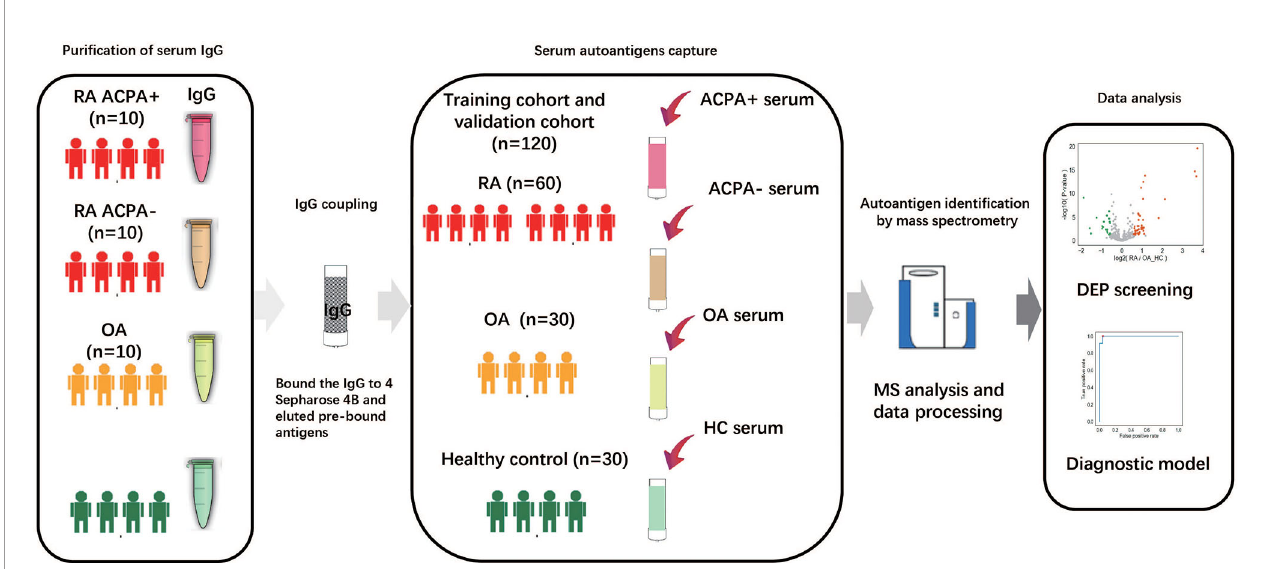
FIGURE 1 | Study overview and antigenome characterization. Overview of the study cohort and schematic work fl ow. RA, rheumatoid arthritis; OA, osteoarthritis; ACPA, anti-citrullinated protein antibody; HC, healthy control; MS, mass spectrometry; DEP, differentially expressed